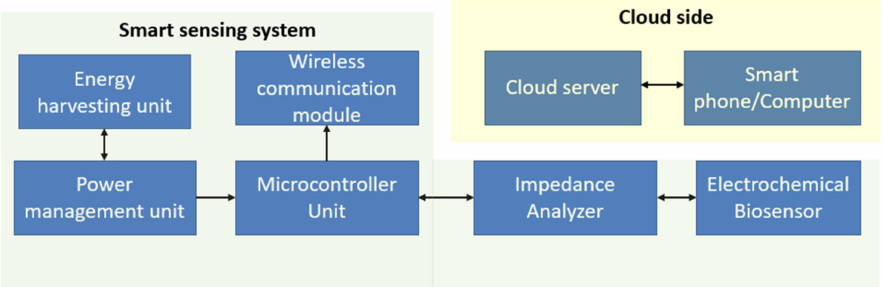
Figure 7. Schematic diagram of an online monitoring